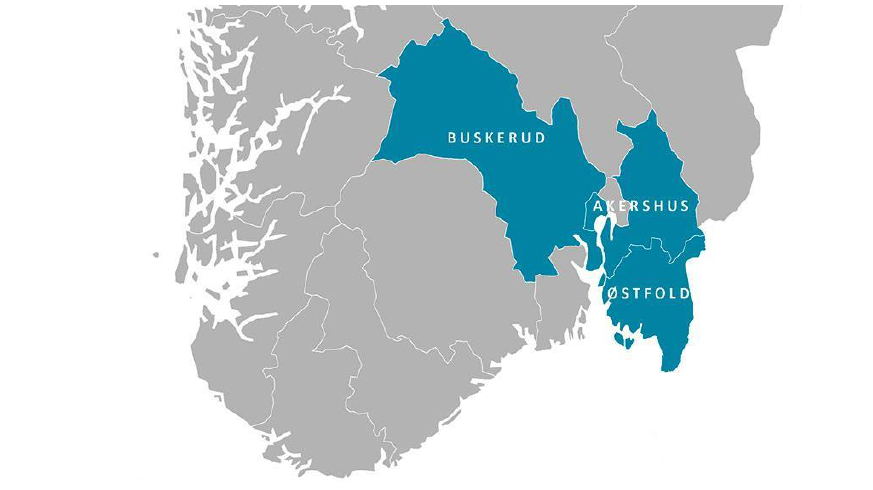
Figure 2. Location of Viken county